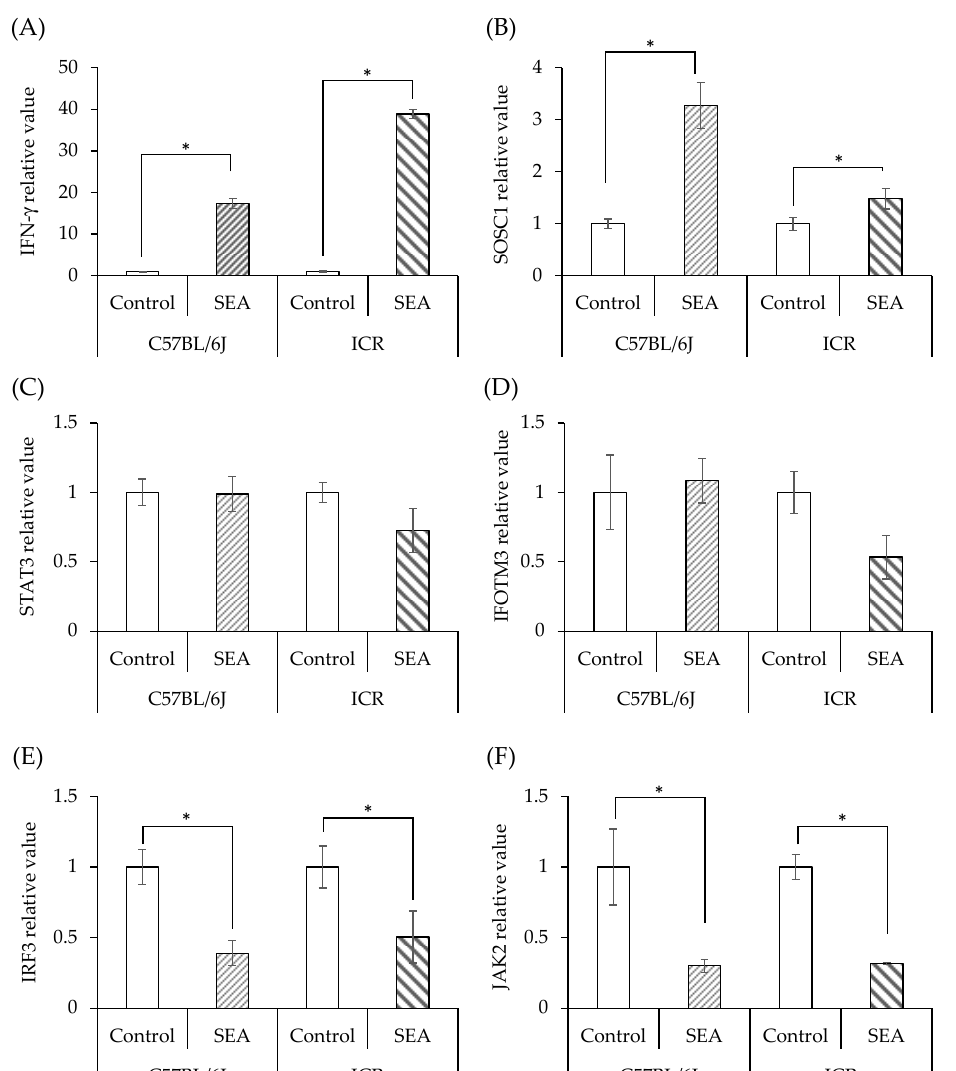
Figure 4. Comparison of SEA-induced JAK/STAT pathway-related gene expression in spleen cells from normal C57BL/6J and ICR mice. ( A ) IFN- γ , ( B ) SOCS1, ( C ) STAT3, ( D ) IFITM3, ( E ) IRF3, ( F ) JAK2. Spleen cells from normal mice (C57BL/6J and ICR mice) were exposed to SEA (50 ng/mL), and the expression of JAK/STAT pathway-related genes was examined by real-time RT-PCR. Gene expression was normalized to Hprt gene expression. The fold change was determined relative to the control without SEA. * p < 0.05 compared to the control. The values represent the mean ± standard deviation of three independent experiments.